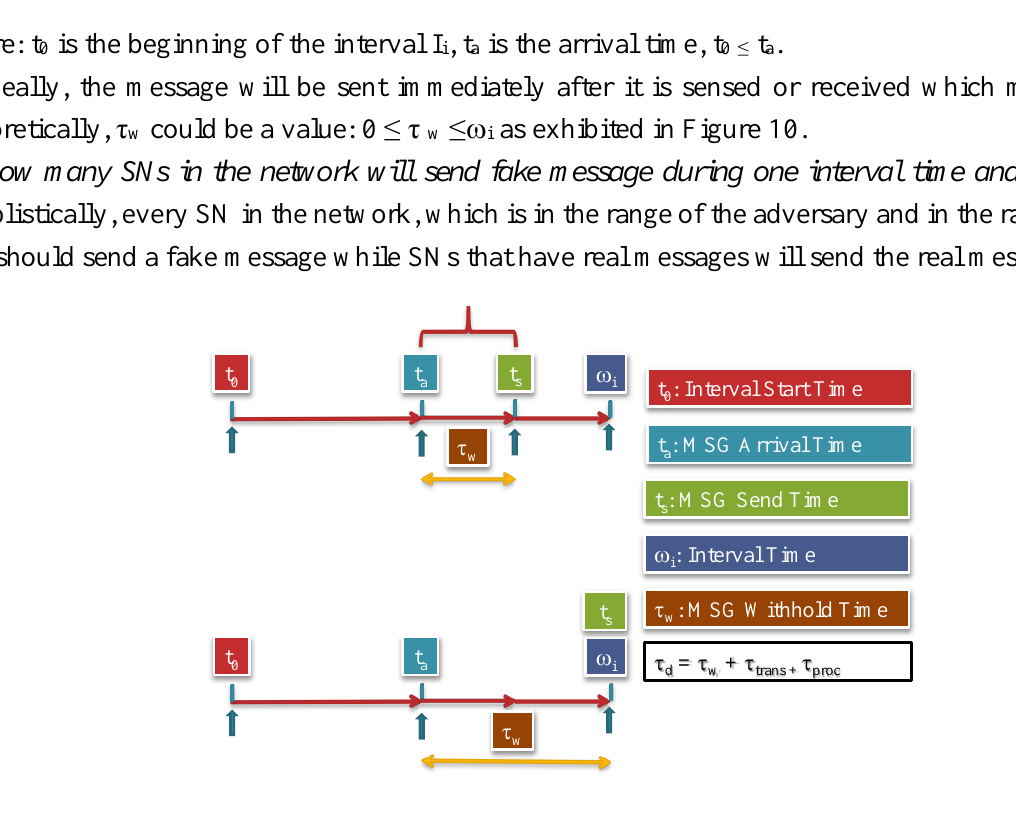
Figure 10. Timing for receiving a real message and then sending it out during the interval period assigned to the sensor node. The total delay will include the processing time, transmission time and the withhold time